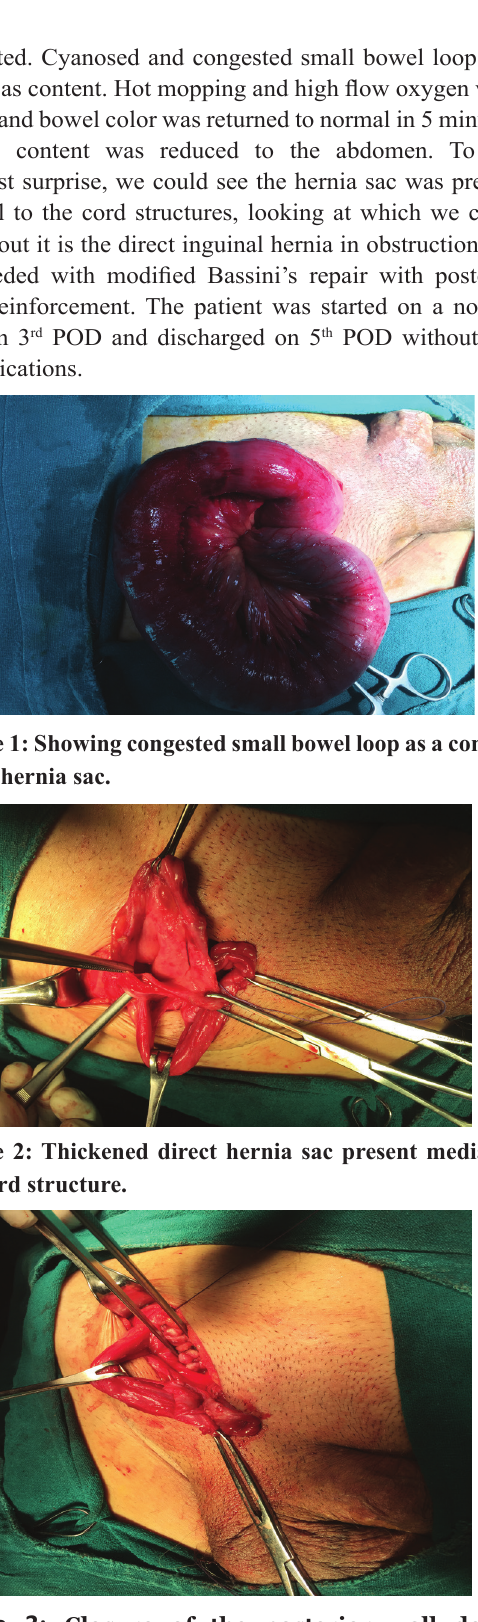
Figure 3: Closure of the posterior wall defect (cid:68)(cid:81)(cid:71)(cid:3) (cid:48)(cid:82)(cid:71)(cid:76)(cid:191)(cid:72)(cid:71)(cid:3) (cid:37)(cid:68)(cid:86)(cid:86)(cid:76)(cid:81)(cid:76)(cid:182)(cid:86)(cid:3) (cid:85)(cid:72)(cid:83)(cid:68)(cid:76)(cid:85)(cid:3) (cid:90)(cid:76)(cid:87)(cid:75)(cid:3) (cid:76)(cid:81)(cid:87)(cid:72)(cid:85)(cid:85)(cid:88)(cid:83)(cid:87)(cid:72)(cid:71)(cid:3)